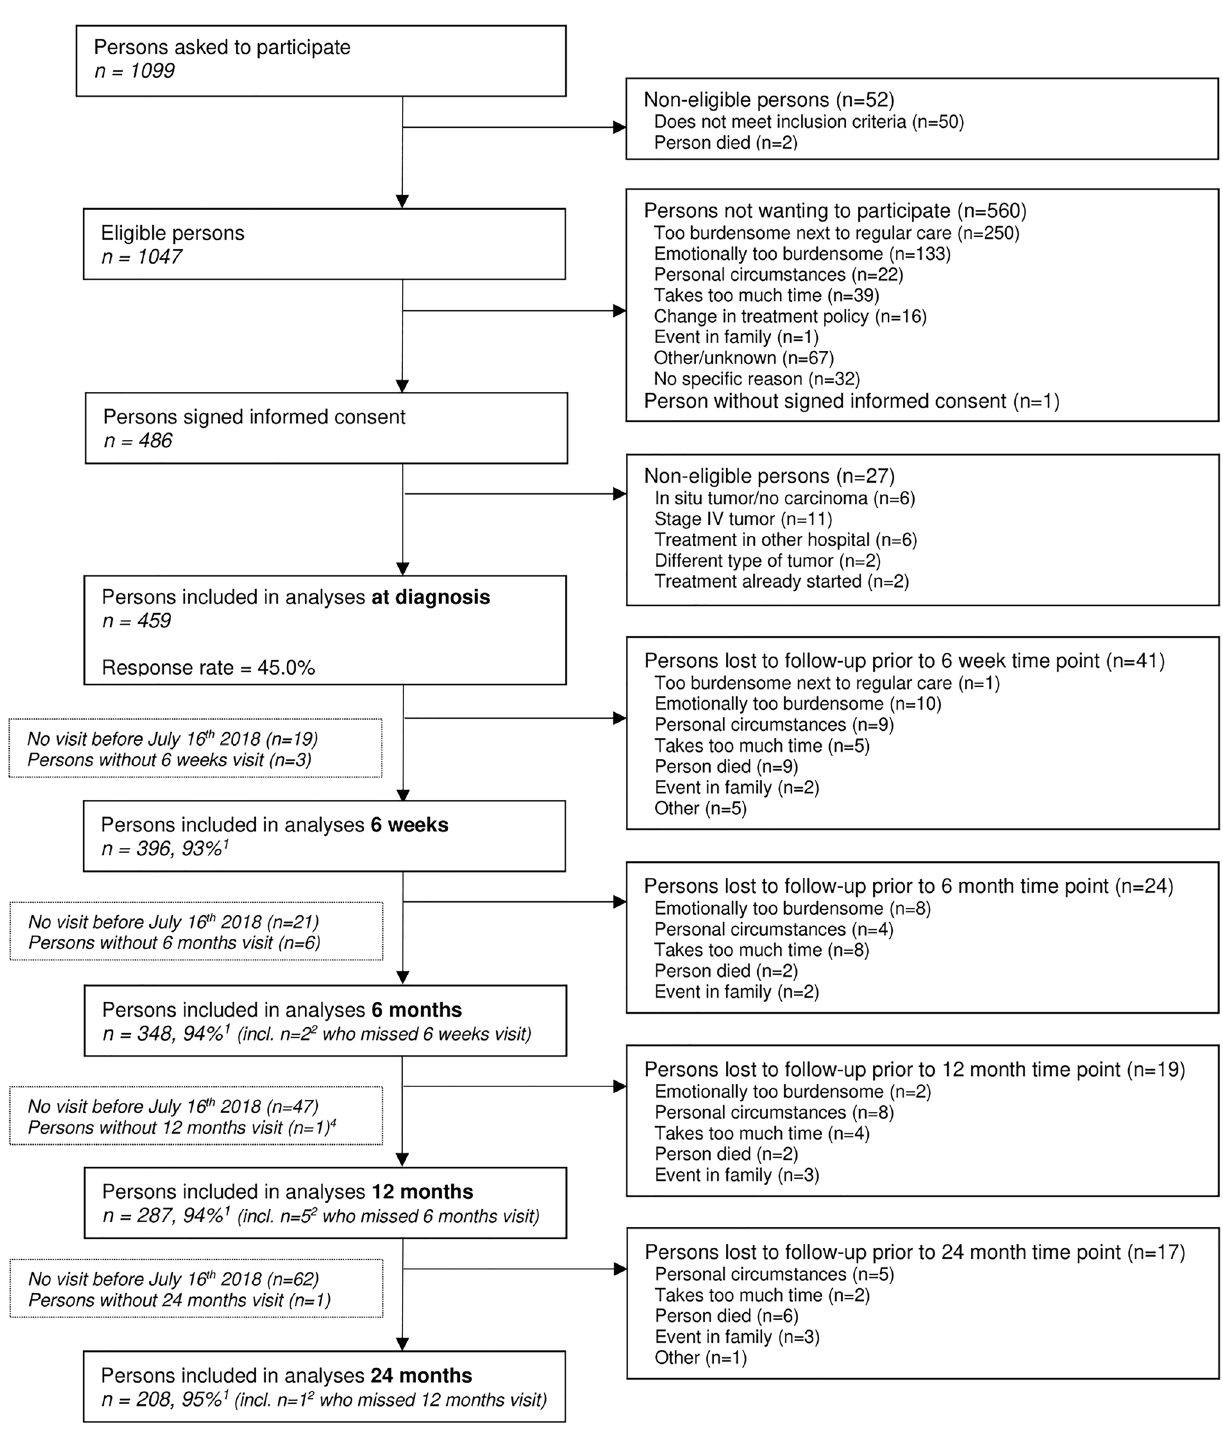
Figure 1. Flow-diagram of inclusion of individuals within the EnCoRe study and included in the analyses presented in this paper. Data of home visits performed before July 16th 2018 were included in the analyses. 1 Response rate post-treatment = (persons included)/(persons included + persons lost to follow − persons died), 2 Of the three persons without 6 weeks follow-up visits, one person did not have a 6 months follow-up visit before July 16th 2018. Of the six persons without 6 months follow-up visits, one person did not have a 12 months follow-up visit before July 16th